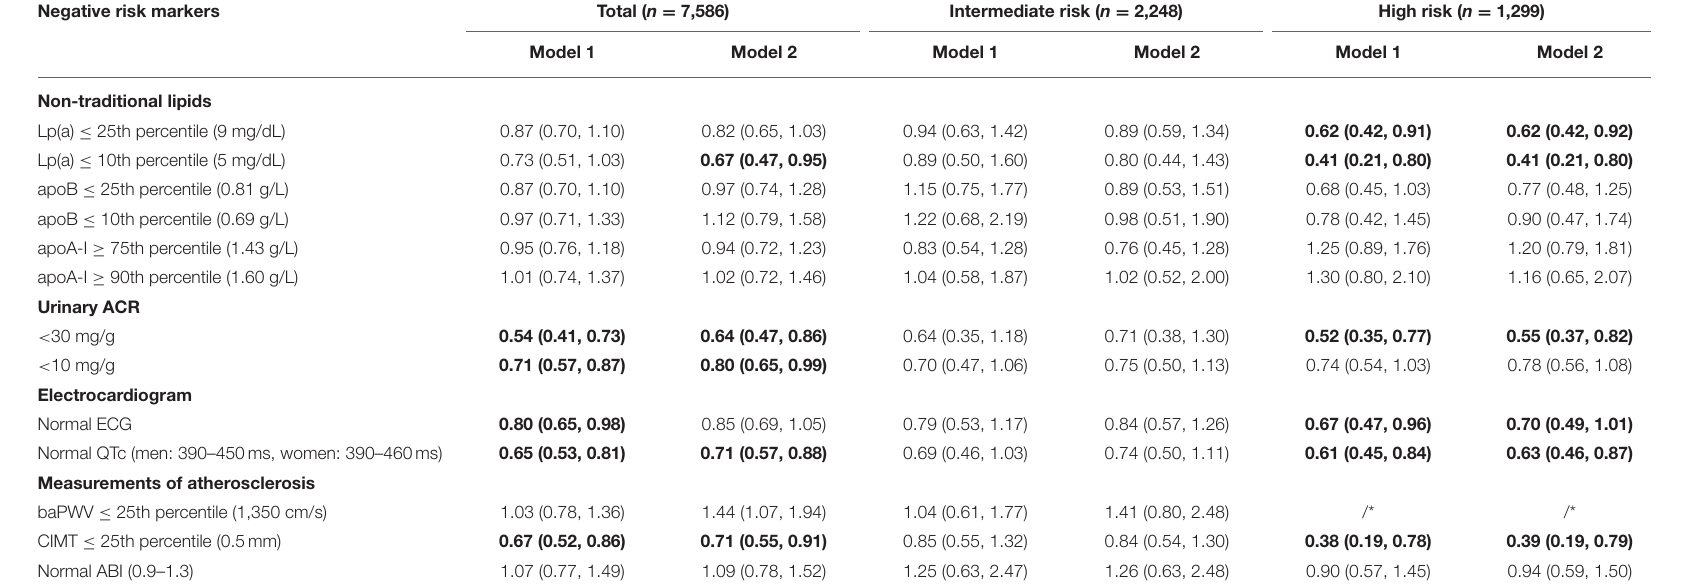
Data are hazard ratios (95% confidence intervals). The bold values indicate statistical significance. Intermediate risk: 10-year ASCVD risk 7.5% to 19.9% by the PCEs; High risk: 10-year ASCVD risk ≥ 20% by the PCEs. Model 1: adjusted for age and sex. Model 2: further adjusted for smoking status, diabetes, total cholesterol, HDL-c, systolic blood pressure, antihypertensive